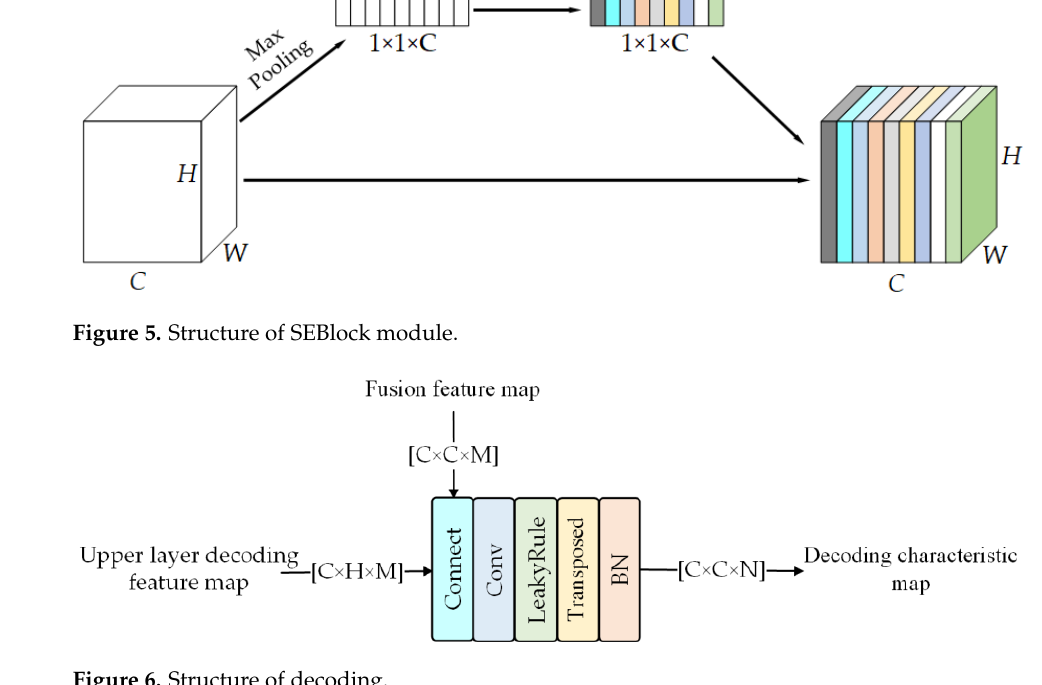
Figure 6. Structure of decoding.